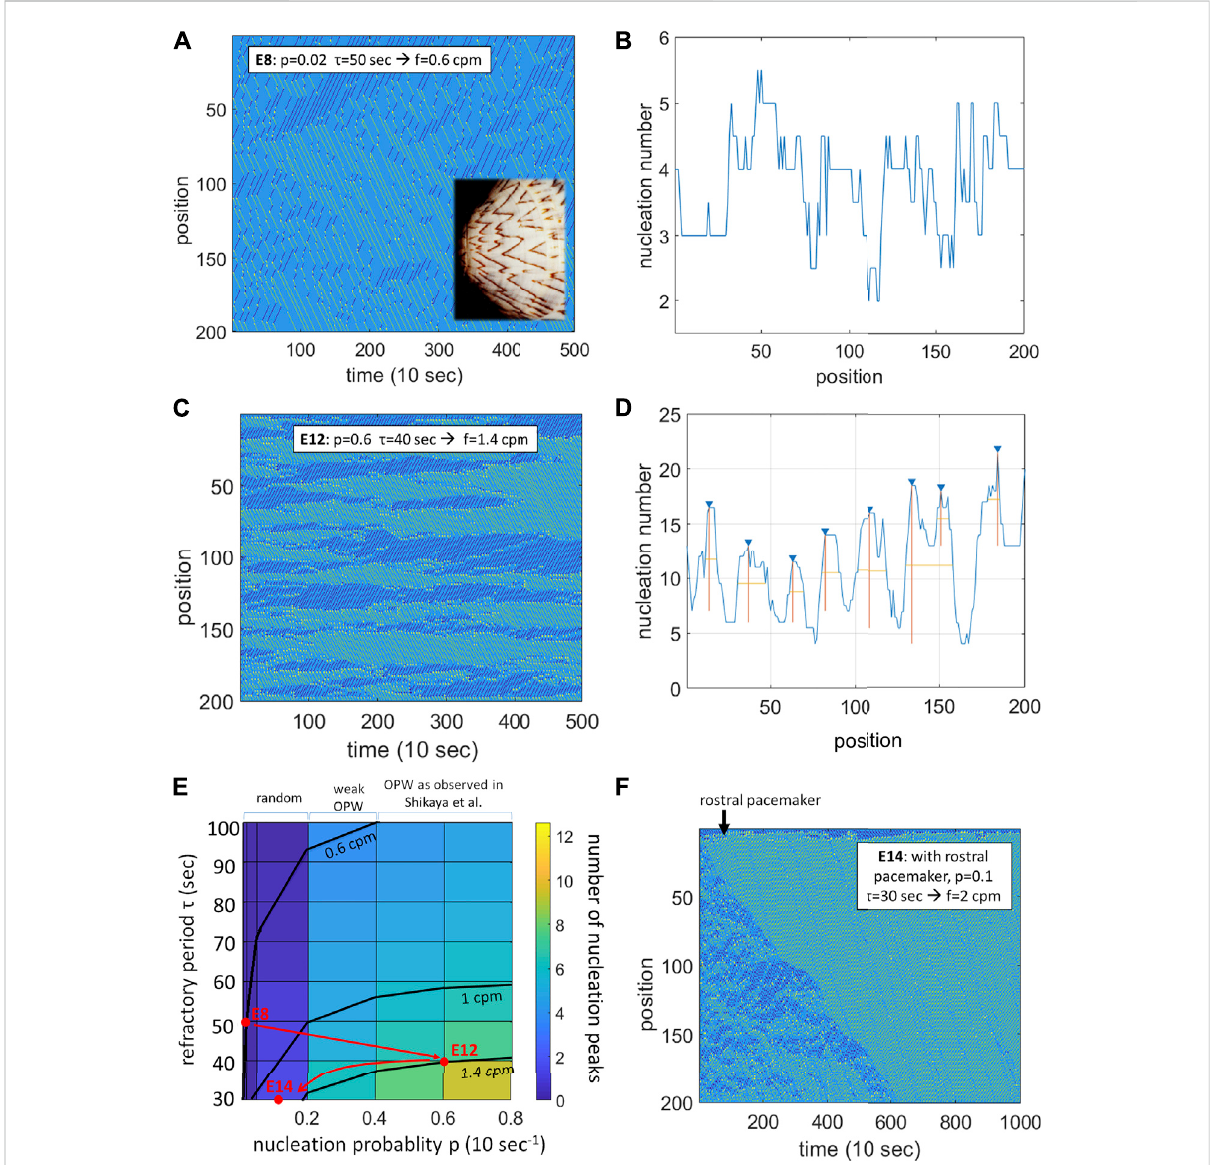
at E8, E12 and E14. (A) Spatiotemporal map for p = 0.02, τ = 50 s, yielding f = 0.6 cpm. Rostro-caudal waves in green, caudo-rostral waves in dark blue, nucleation sites in yellow. Inset: the wave pattern is reminiscent of the pigmentation of some seashells (Meinhardt and Klingler, 1987). (B) Homogeneous distribution of nucleation sites along the gut corresponding to (A) . (C) Spatiotemporal map for p = 0.4, τ = 40 s, yielding f = 1.4 cpm. (D) Peaked distribution of nucleation sites (OPWs) along the gut corresponding to (C) . (E) Color-coded map of the average number of nucleationsites(OPWs)asafunctionoftherefractoryperiod τ andofthenucleationprobability p .Frequencyisolinesat0.6,1and1.4 cpmareshown. Red dots: parameters used in (A,C,F) with the suggested developmental trajectory. (F) Spatiotemporal map for p = 0.1, τ = 30 s with an additional rostralpacemaker p rostral (cid:1) cos ( 2 π ft ) with f =2 cpm.Thediagramisprogressivelyinvadedbyrostro-caudalwavesfromthepacemakersitewhenthe nucleation probability in the rest of the gut smooth muscle is low